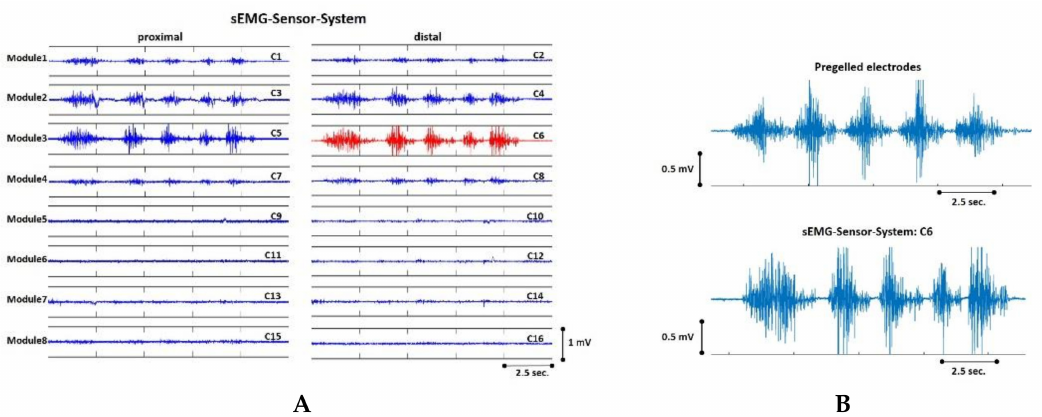
Figure 5. ( A ) Representation of the 16 sEMG signals of the sensor system. The sEMG signals were based on five repetitions of an elbow flexor / extension movement. Channel C6 of the sensor system was identified by the algorithm described in Section 2.1.3 as the first relevant channel, which in this case prevents biceps activation. ( B ) Comparison of the first relevant channel C6 with a sEMG signal of the same subject recorded with a commercial sEMG system using pre-gelled